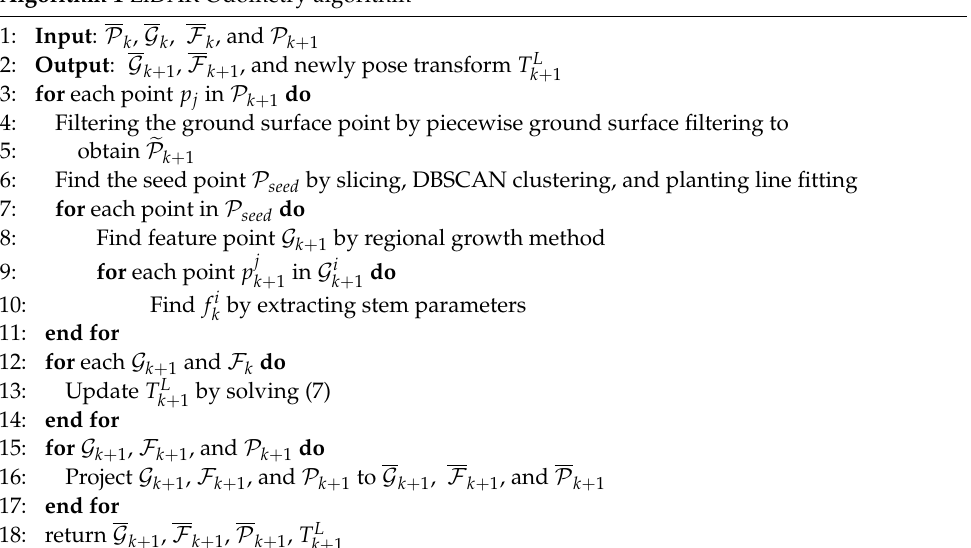
Algorithm 1 LiDAR Odometry